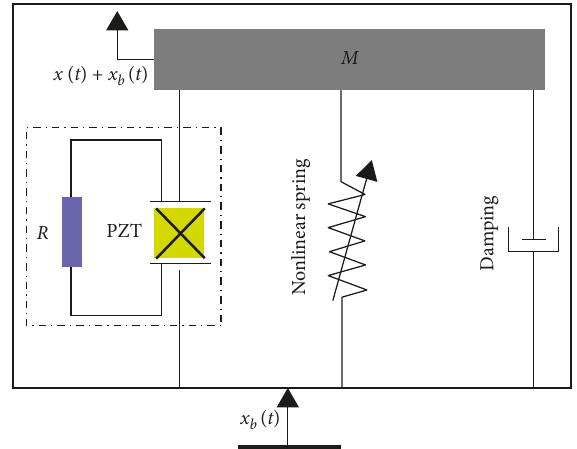
Figure 2: Equivalent schematic diagram of the general piezoelectric vibrational multistable energy harvester.